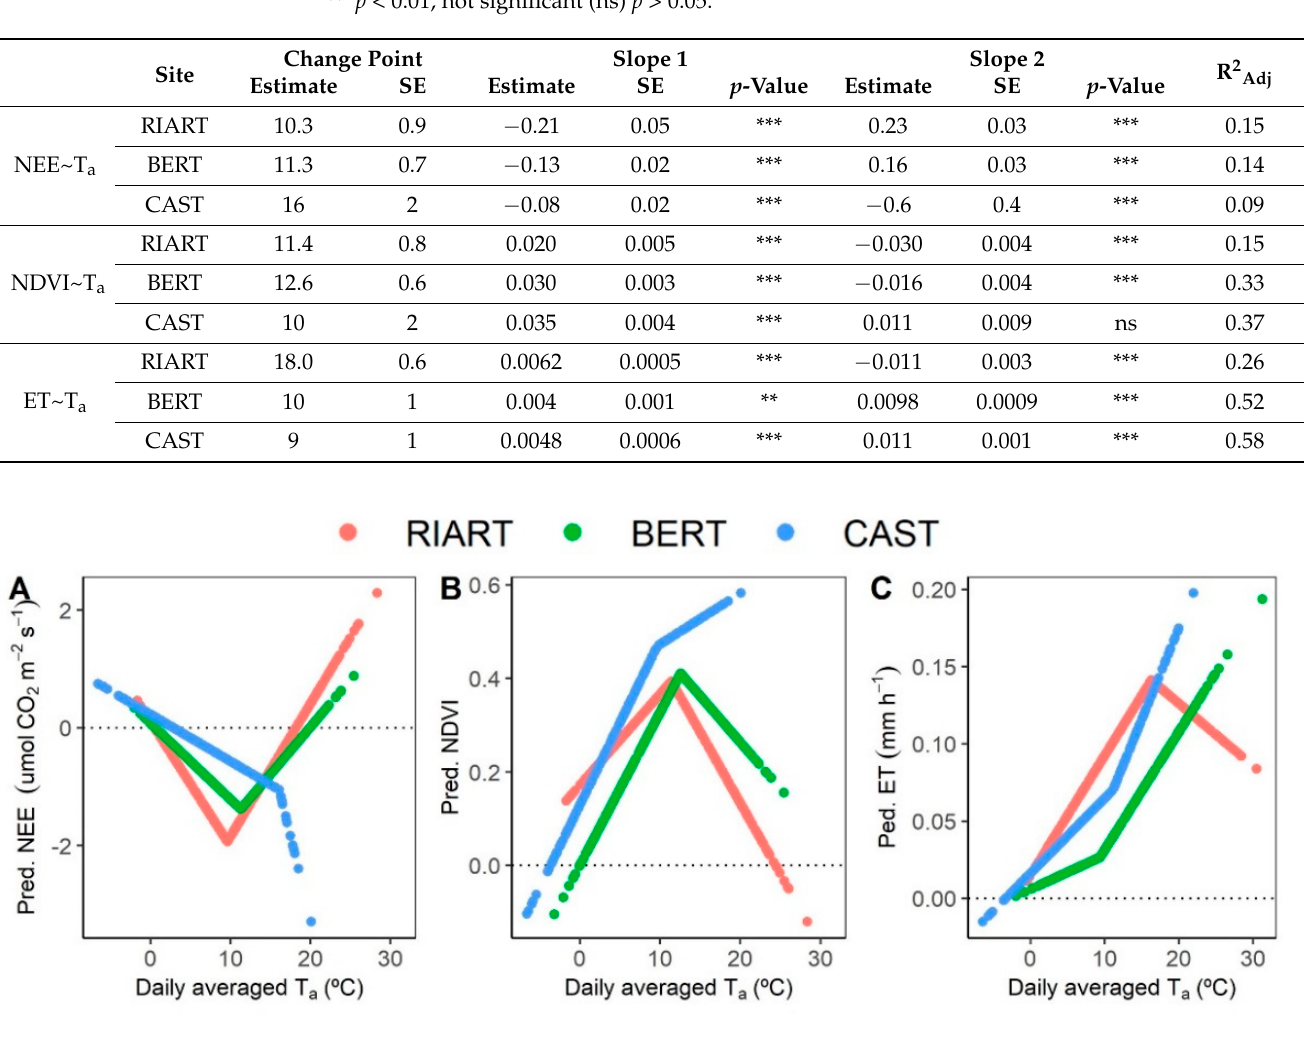
Figure 8. Daily averaged ( A ) normalized vegetation index (NDVI) as function of ambient tempera- ture (T a ); ( B ) evapotranspiration (ET) as function of ambient temperature (T a ).